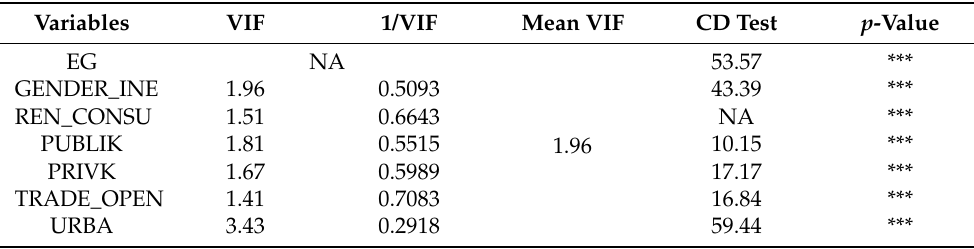
Table 6. VIF and Pesaran CD tests.